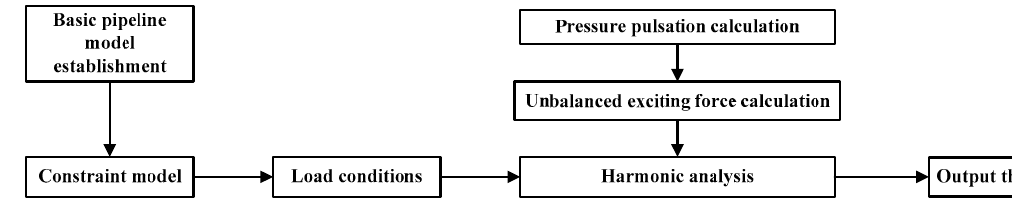
Figure 1. Vibration analysis process of a reciprocating pump pipeline.